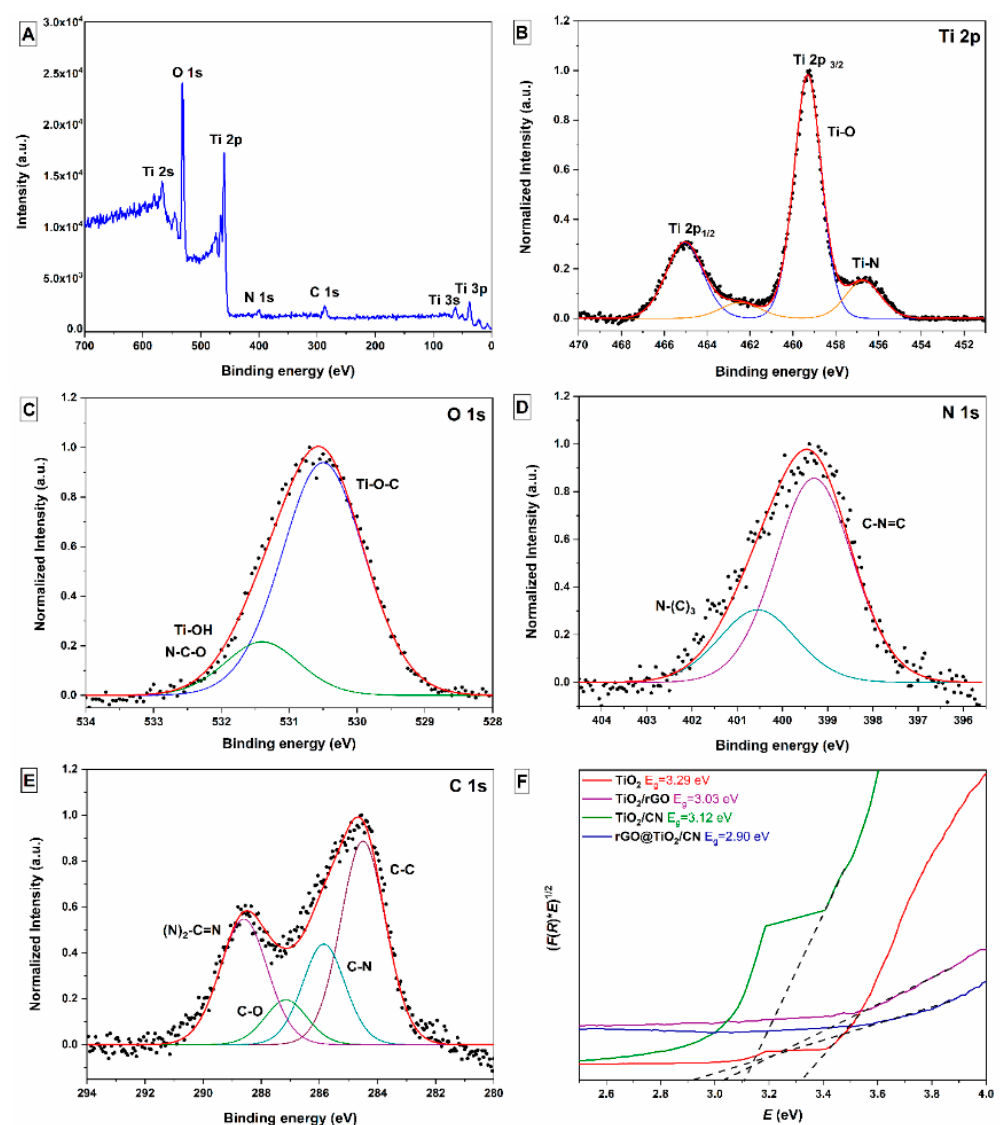
Figure 5. High-resolution XPS spectra of the as-prepared rGO@TiO 2 /CN sample: ( A ) fully scanned spectrum, ( B ) Ti 2p, ( C ) O 1s, ( D ) N 1s, ( E ) C 1s, and ( F ) band gap energies ( E g ) of prepared pure TiO 2 nanoparticles, TiO 2 /rGO, and TiO 2 /CN nanocomposites, and rGO@TiO 2 /CN hybrid.